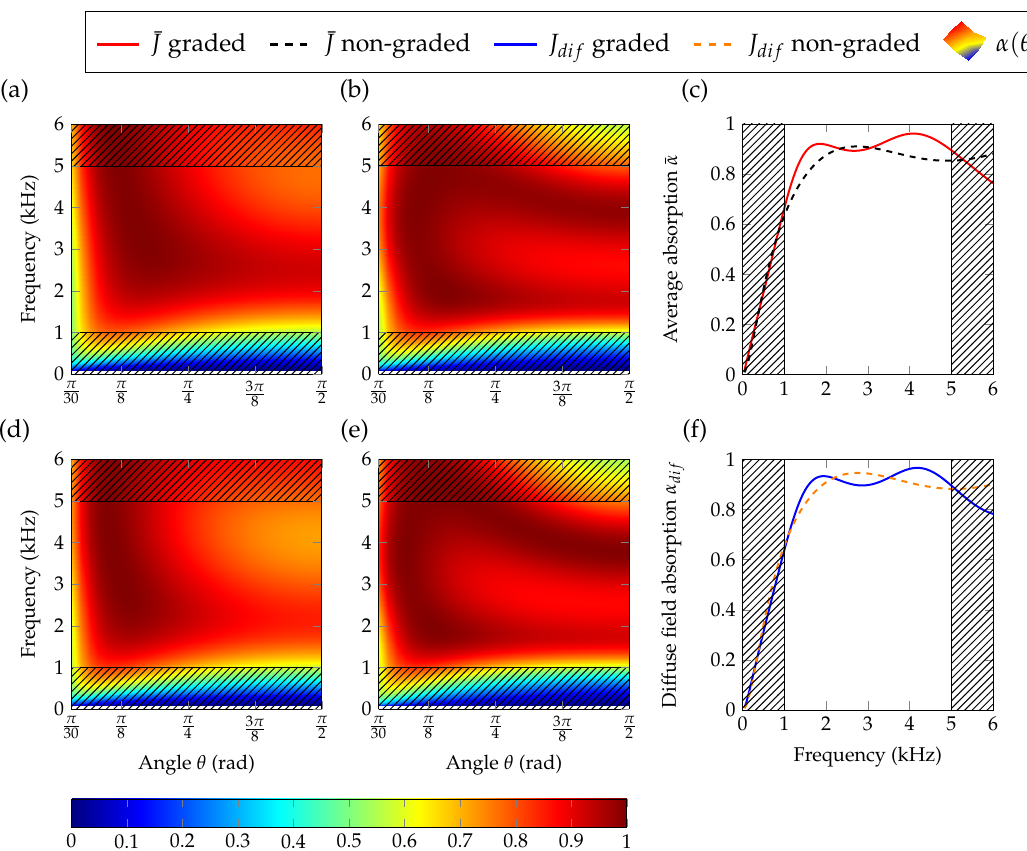
Figure 9. (Color online) Absorption maps with respect to elevation angle and frequency for broadband optimization. The results for optimized average absorption, both non-graded and graded, are shown respectively in ( a , b ). The maps ( d , e ) display the absorption map for optimized diffuse field absorption coefficient, respectively for non-graded and graded medium. Average absorption is given in ( c ), for graded and non-graded cases in solid red and dashed black respectively. The diffuse field absorption coefficient is shown in ( f ), for graded and non-graded cases in solid blue and dashed orange